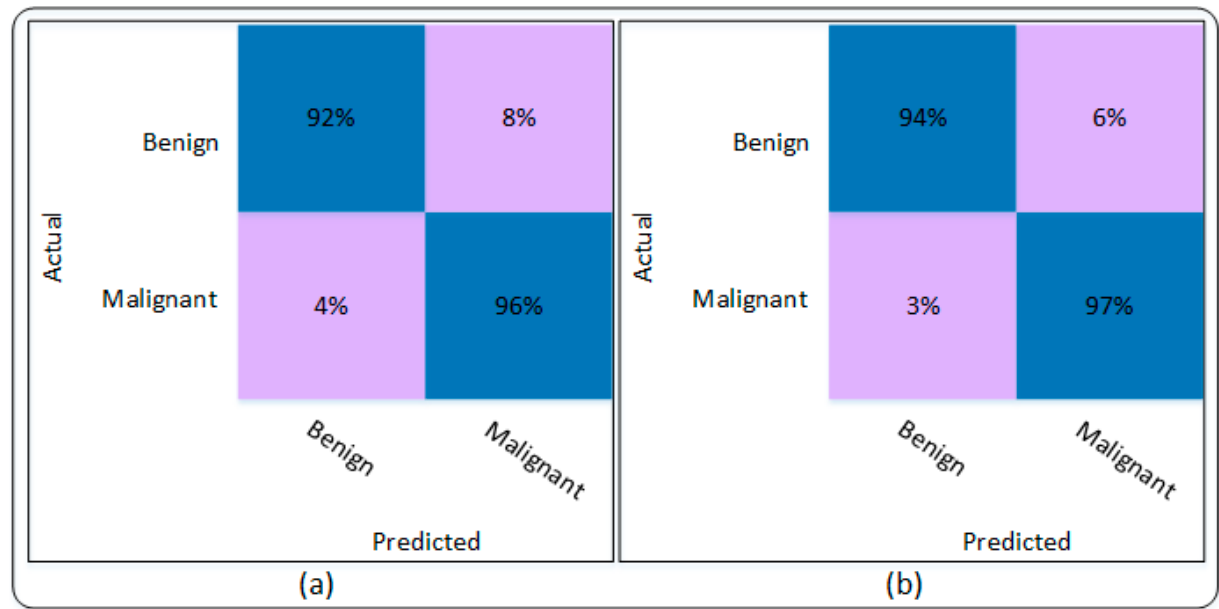
Figure 9. Confusion matrix of the proposed technique. ( a ) DenseNet201 model, ( b ) Modified DenseNet201 model.